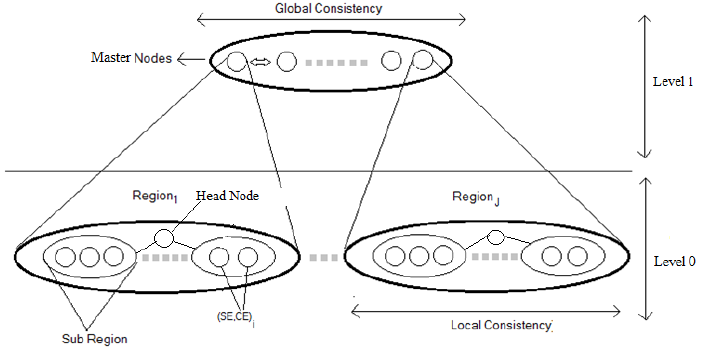
Figure 1. High level view of RCCR approach